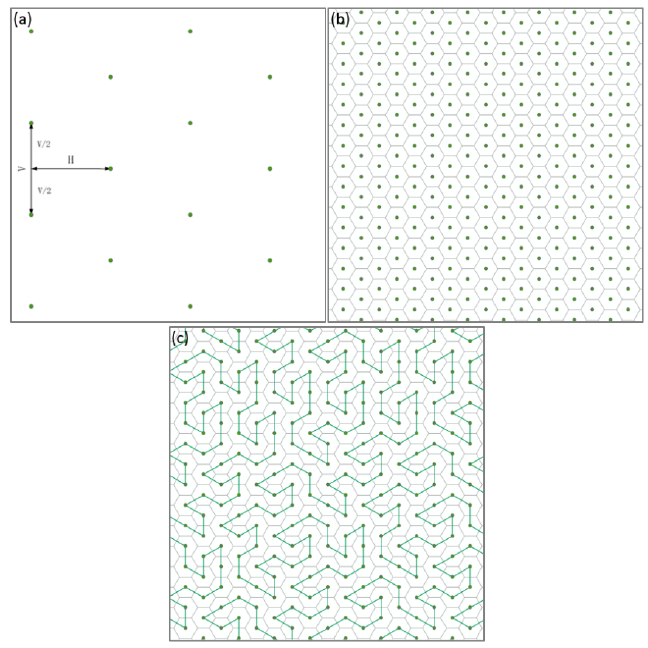
Figure 2. The construction of a hexagon base map and Gosper curve: ( a ) discrete points generated by a certain rule; ( b ) Thiessen polygons generated by discrete points; ( c ) Gosper curve corresponding to the hexagon base map.